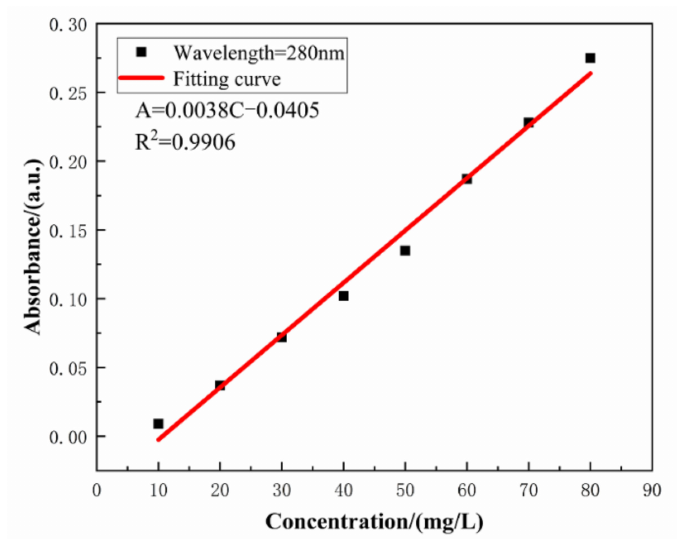
Figure 4. The concentration dependent absorbance of SLS in aqueous